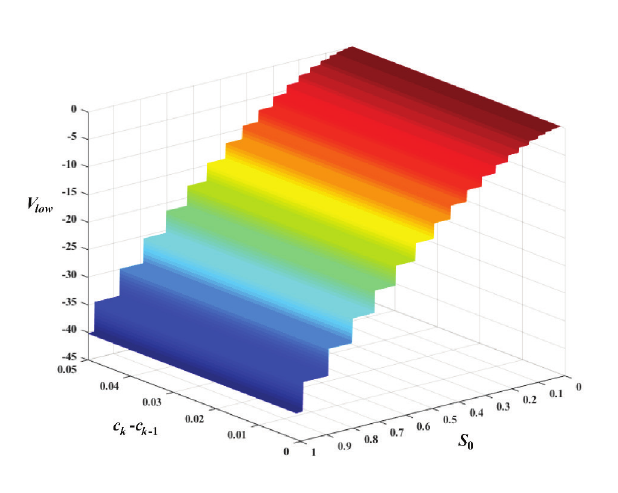
Figure 8. Relationship between low V , S 0 and c −